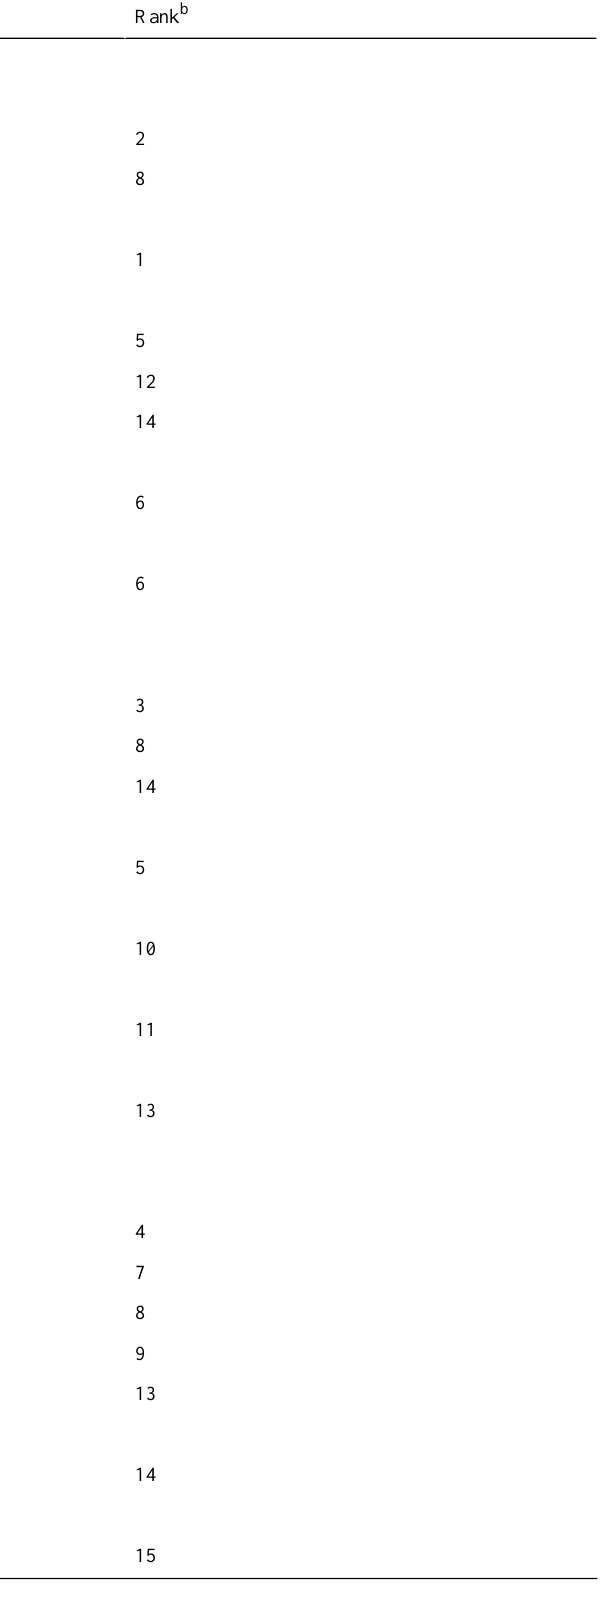
Table 1. LiveWell coaching script